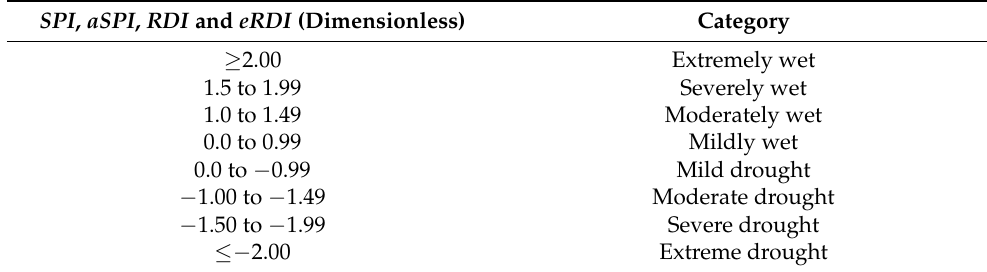
Table 1. Classification of the indices SPI , aSPI , RDI and eRDI for Sinaloa. Source: Authors, from (Tsakiris et al. (2007) and Proutsos and Tigkas (2020) [26,46]). SPI , aSPI , RDI and eRDI (Dimensionless) Category ≥ 2.00 Extremely wet 1.5 to 1.99 Severely wet 1.0 to 1.49 Moderately wet 0.0 to 0.99 Mildly wet 0.0 to − 0.99 Mild drought − 1.00 to − 1.49 Moderate drought − 1.50 to − 1.99 Severe drought ≤− 2.00 Extreme